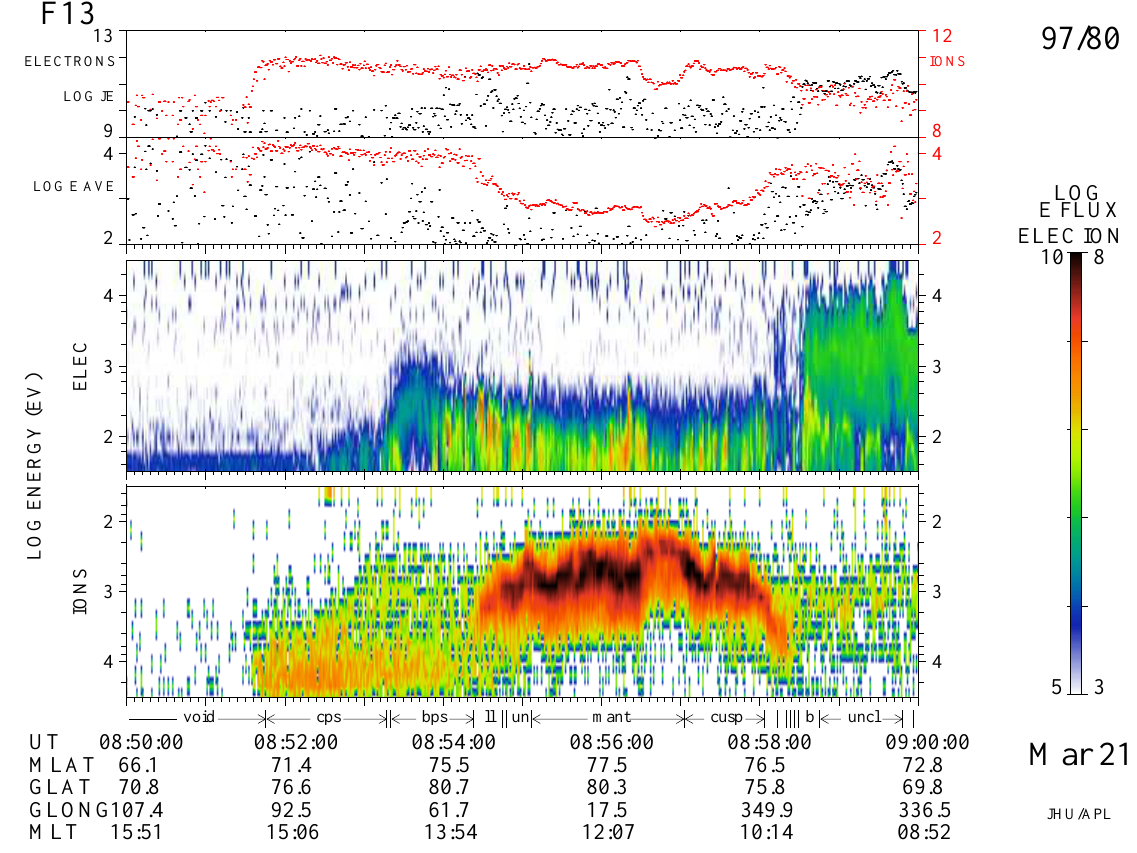
Fig. 7. Ion and electron energy spectrograms measured by DMSP F13 (adapted according to